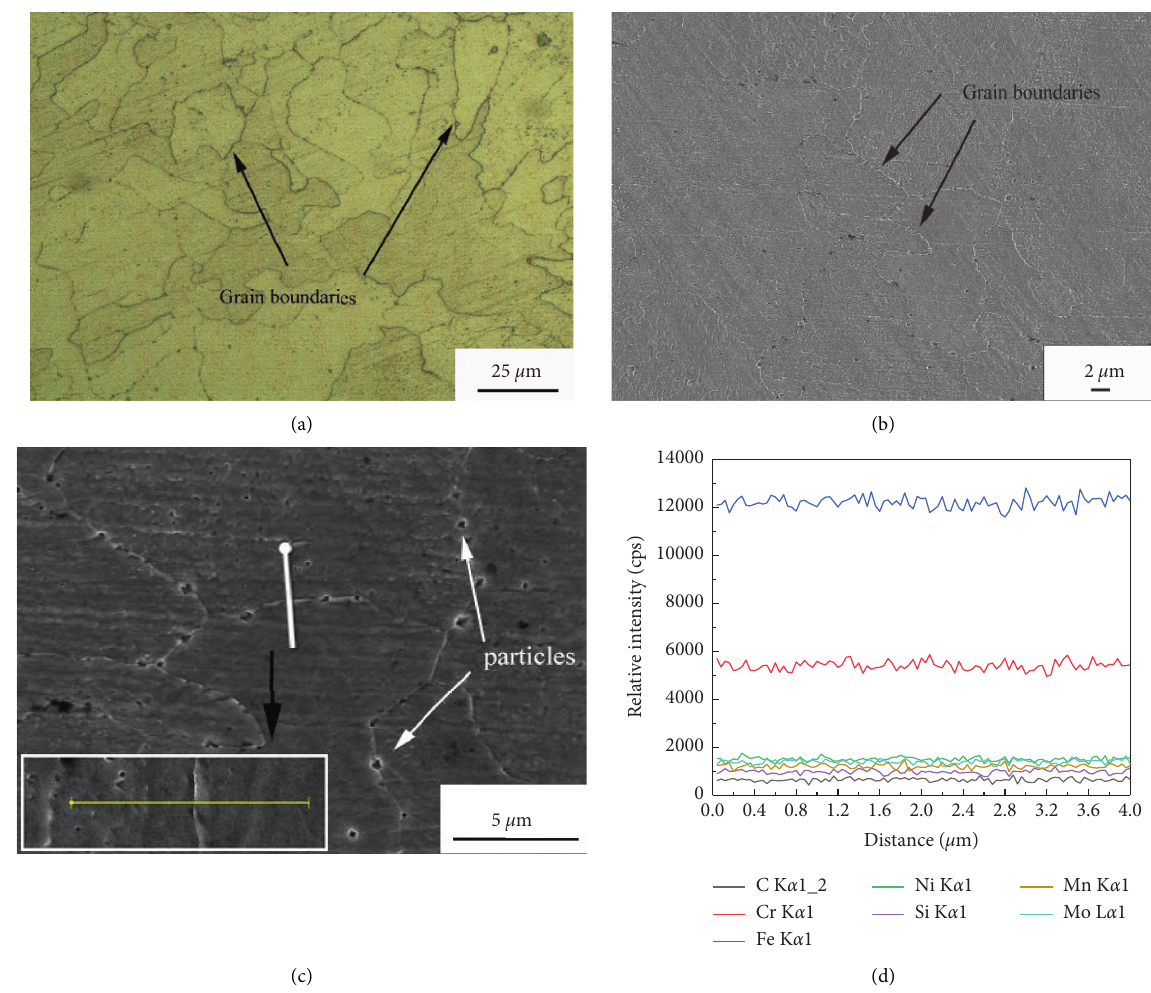
Figure 7: Microstructure and EDS analysis of the solution-treated SLM 316L stainless steel. (a) Grain boundary under OM, (b) grain boundary under SEM, (c) scope of the EDS line scan, and (d) elemental analysis of the EDS line